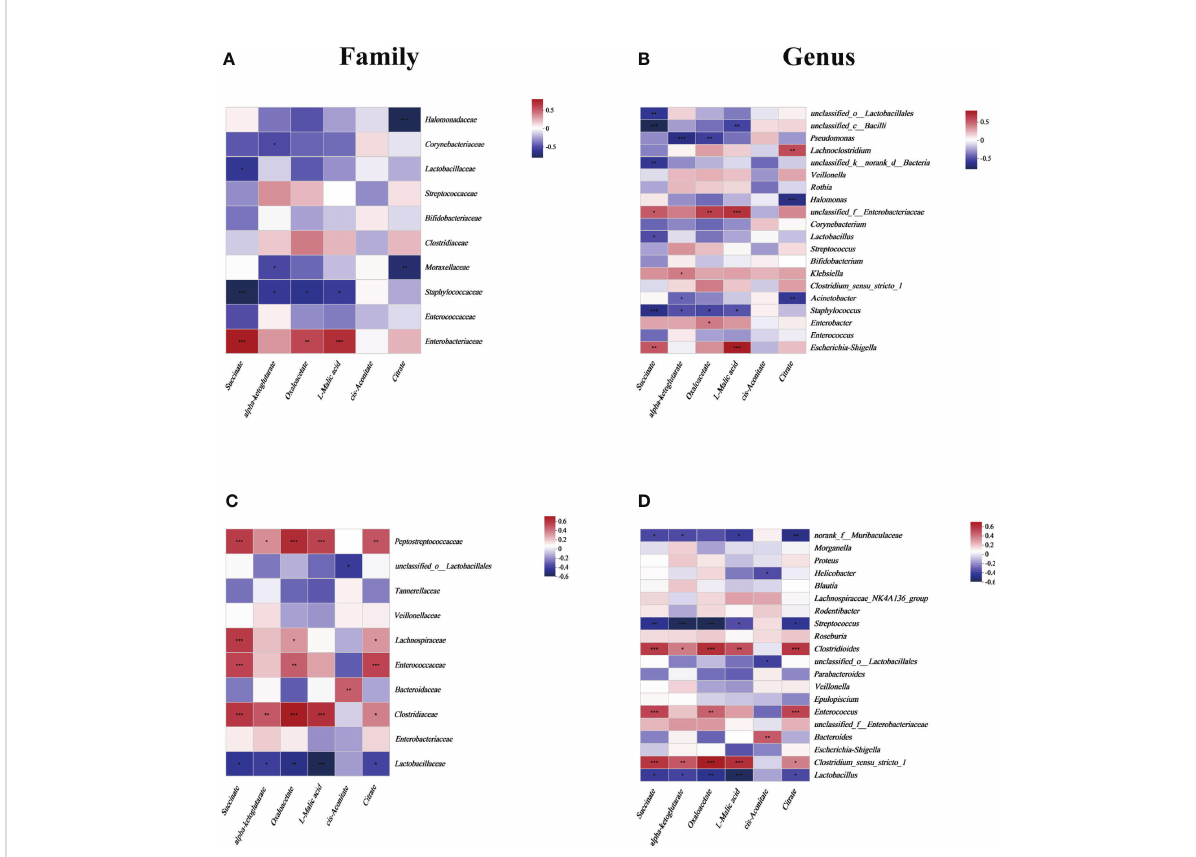
FIGURE 2 The relationship between the gut microbiota and energy metabolites at the (A) family level and (B) genus level in human neonates and at the (C) family level and (D) genus level in mouse pups. In the two-dimensional matrix, the color change re fl ects the data information, and the color depth indicates the data value. The correlation heatmap analysis is based on Spearman rank correlation. Signi fi cant differences are shown by * P < 0.05, ** P < 0.01, *** P <